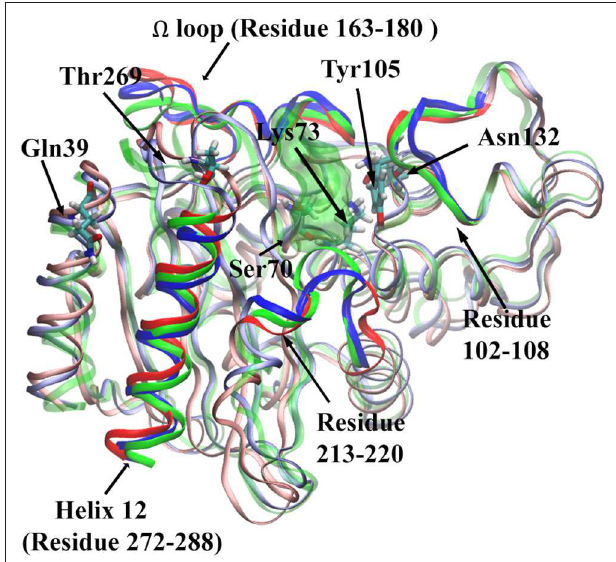
FIGURE 12 | The structure of TEM-1 in apo (blue), reactant (green) and product (red) states. (cid:127) loop (residues 163–180), helix 12 (residues 272–288), residues 102–108, and residues 213–220 are highlighted in each state with same colors. Also key residues Gln39, Thr269, Ser70, Lys73, Tyr105, and Asn132 are labeled. The ligand penicillin-G molecule is represented as green transparent surface.